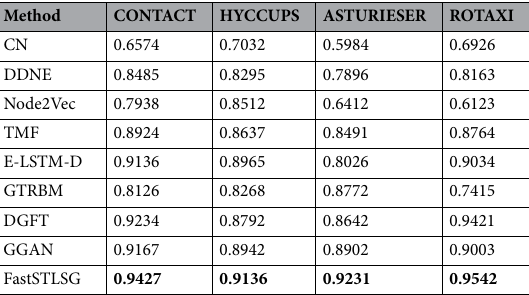
Table 5. Performances on AUC for different methods. Significant values are in bold.